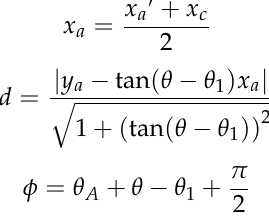
Figure 13. Multi-flexible fingers harvesting model of pineapple.